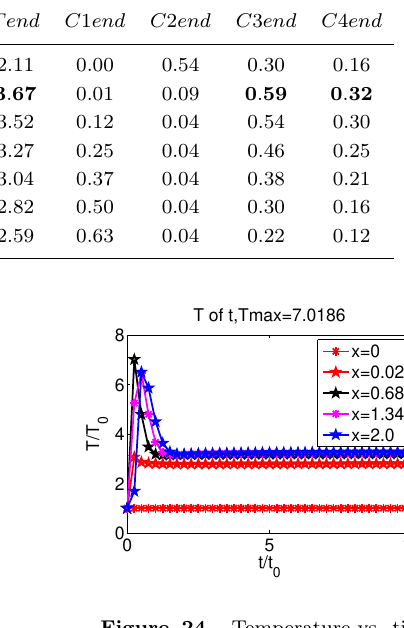
Figure 23. Temperature vs. x with fixed t .